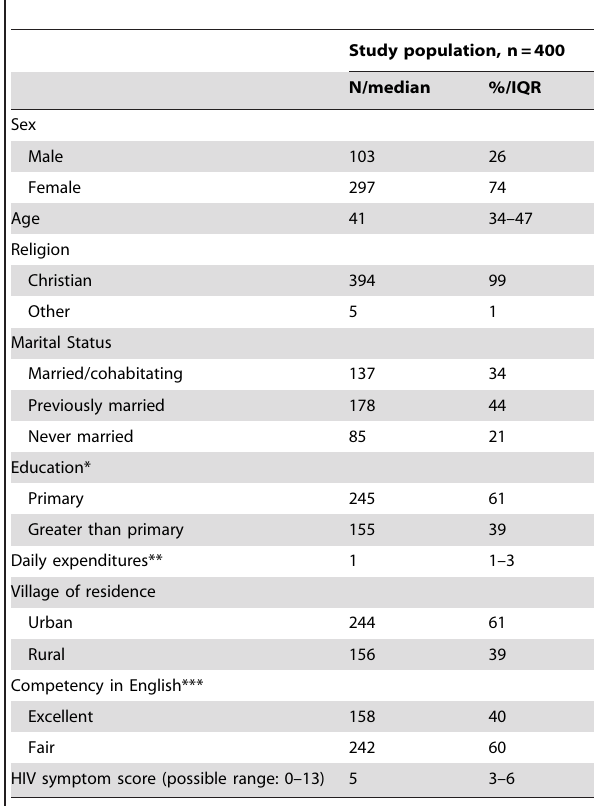
Table 1. Characteristics of the overall study population (N [%] or median [IQR]).